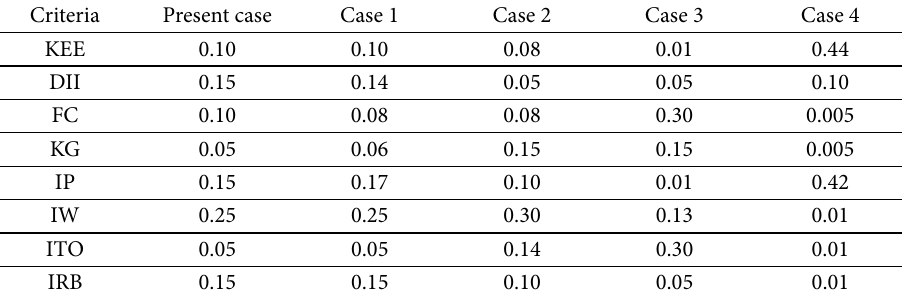
Table 9. Cases for sensitivity analysis